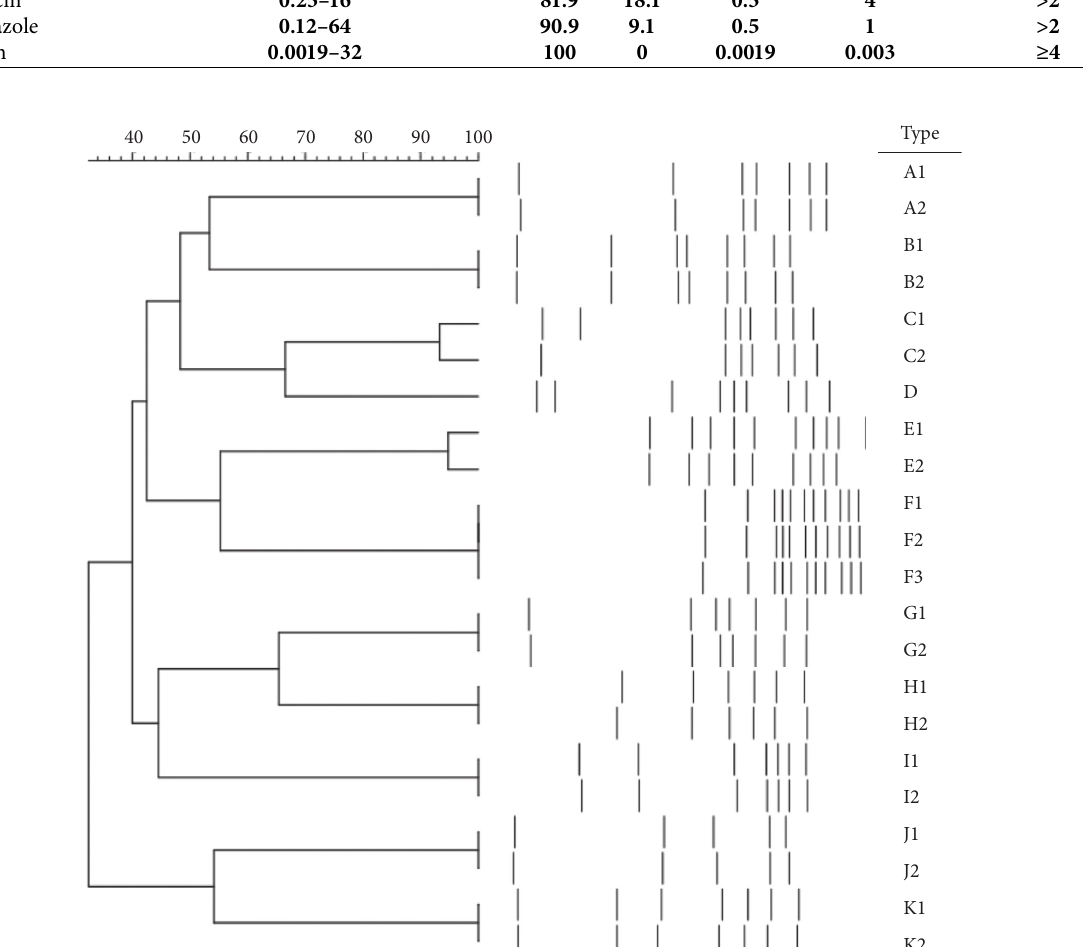
Figure 2: Dendrogram showing PFGE types and their correlations between isolated toxigenic or nontoxigenic Clostridium difficile